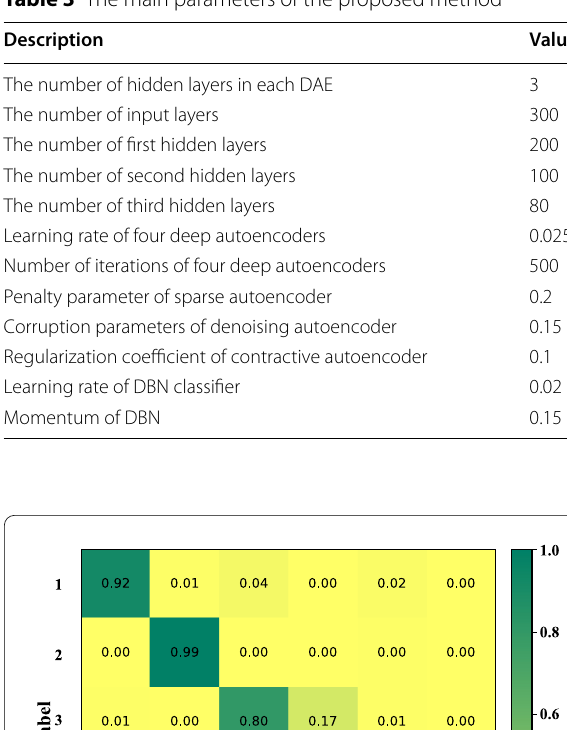
Table 3 The main parameters of the proposed method